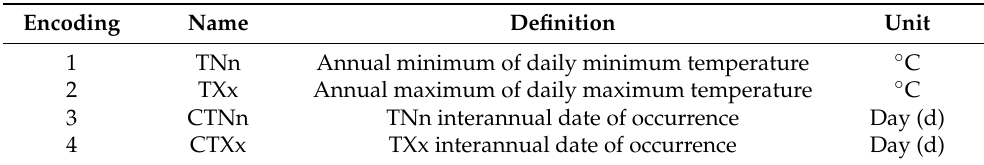
Table 1. Extreme temperature indices selected and defined.